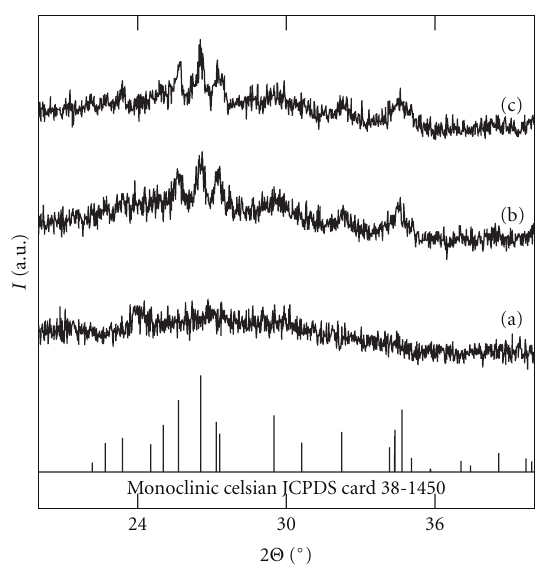
Figure 1: XRD patterns of sample 1 thermally treated at 200 ◦ C for 2 hours (a), heated at 500 ◦ C and then cooled down in air atmosphere (b), and thermally treated at 800 ◦ C for 28 hours (c).